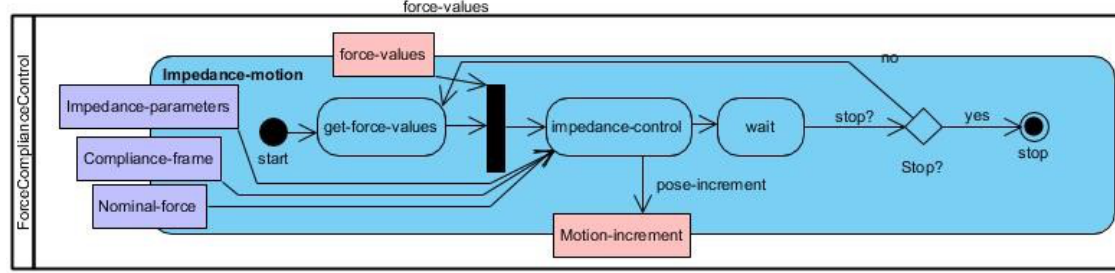
Figure 1: Primitive skill: impedance controlled contact motion